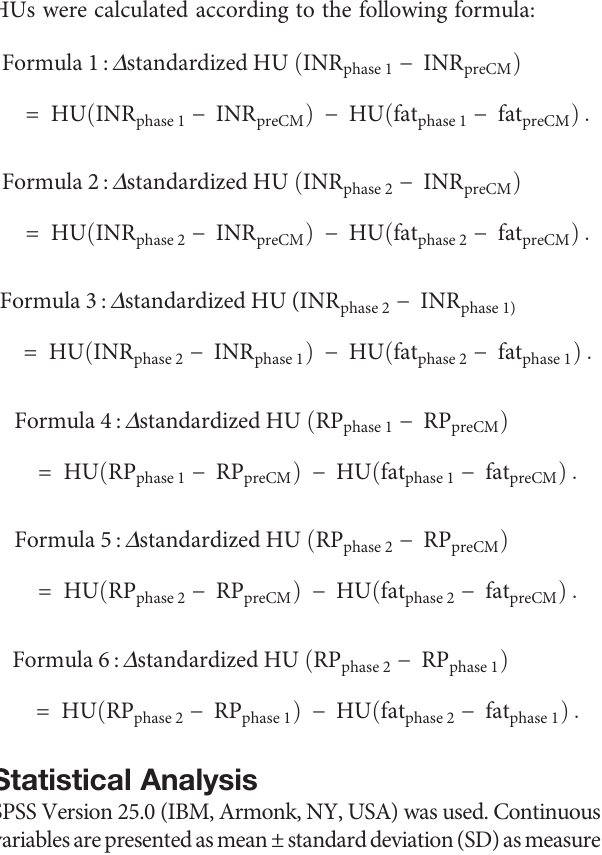
TABLE 1 | The clinicopathological data and molecular pathological subtypes of these